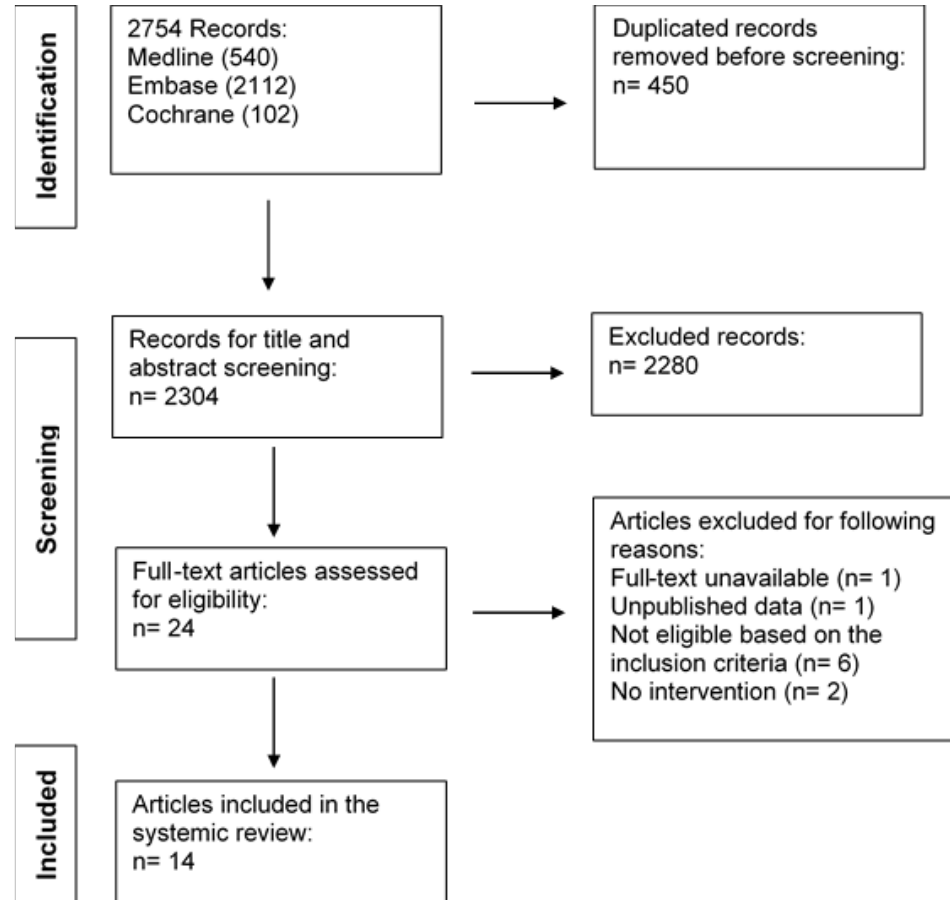
Figure 1. PRISMA flow diagram of the literature search in three selected databases (Medline, Embase, and Cochrane library) and the screening process of included studies. Table 1. Characteristics of included studies on vitamin D supplementation interventions.